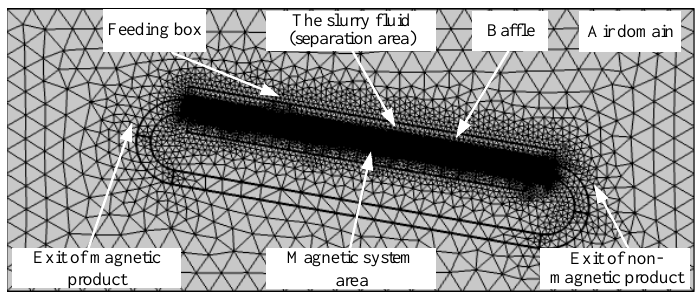
Figure 3. Model meshing. Table 1. Main parameters of simulation.